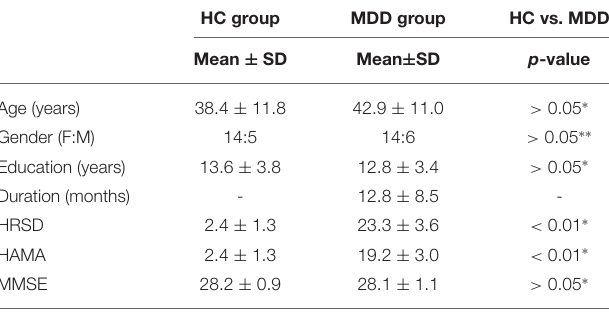
TABLE 1 | Basic information of the participants in HC and MDD